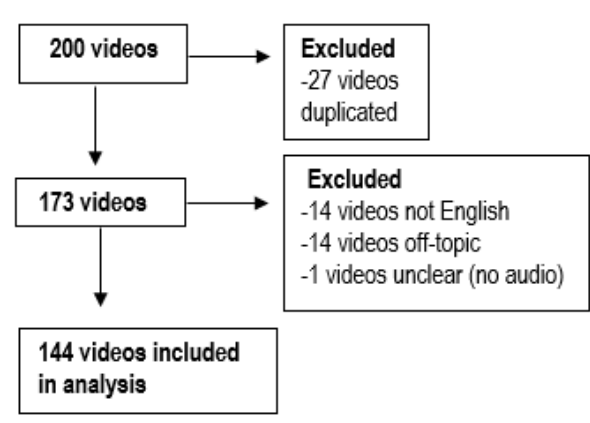
Figure 1. The screening process for